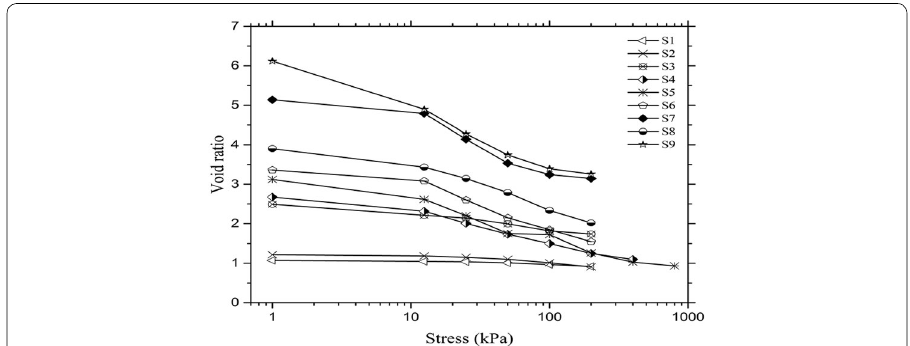
Fig. 4 Consolidation curves of the homogeneous soil